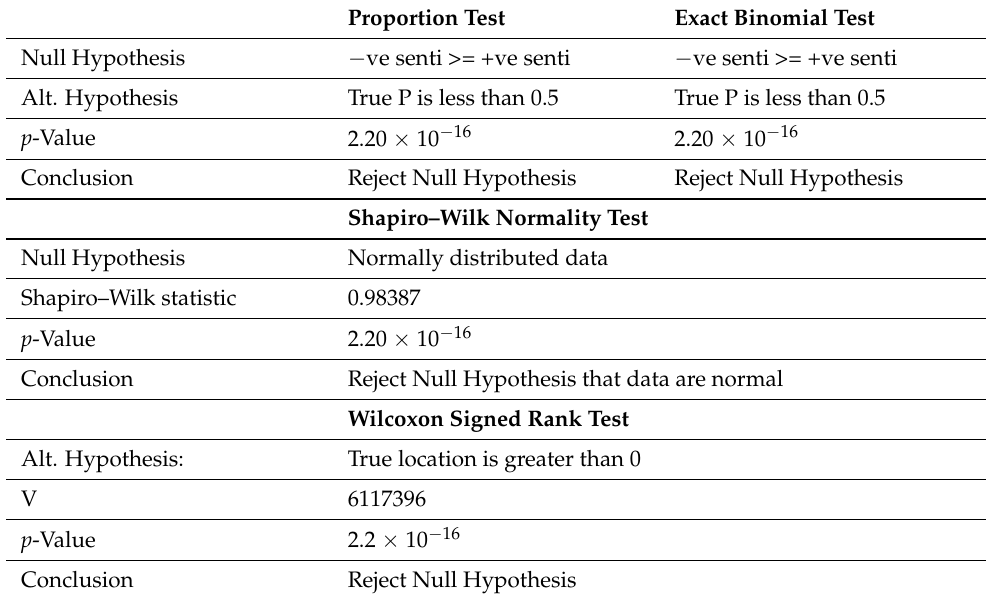
Figure 9. Sorted sentiment score barplots ( a ) February 2021. ( b ) March 2021. Table 2. Statistical tests for positive and negative sentiment counts for February 2021. ( a ) Proportion test for positive sentiment. ( b ) Shapiro–Wilk normality test for sentiment scores. ( c ) Wilcoxon signed rank test for the mean of the sentiment